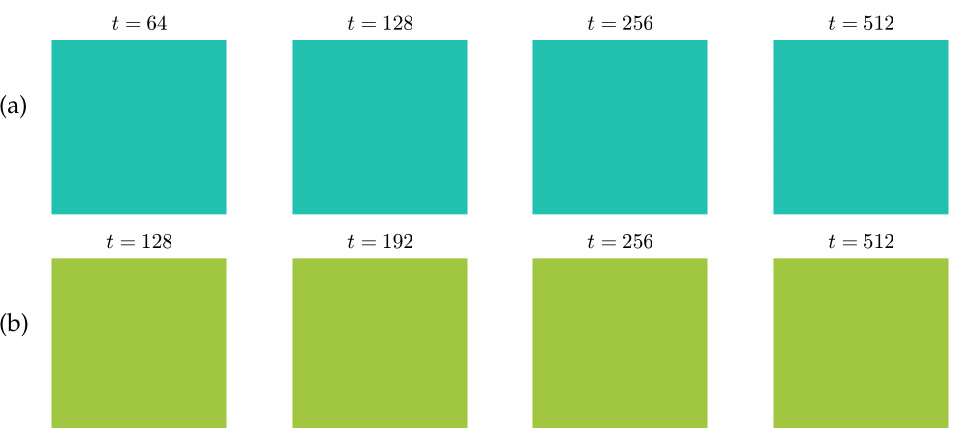
Figure 2. ( a ) Evolution of F ( t ) with several time steps. ( b ) Evolution of φ ( x , y , t ) with (cid:101) = 0.25, ∆ x = ∆ y = 1 , and ∆ t = 2 − 4 . The yellow, green, and blue regions show φ = 0.6288, 0.0688, and 3 − 0.4913, respectively.